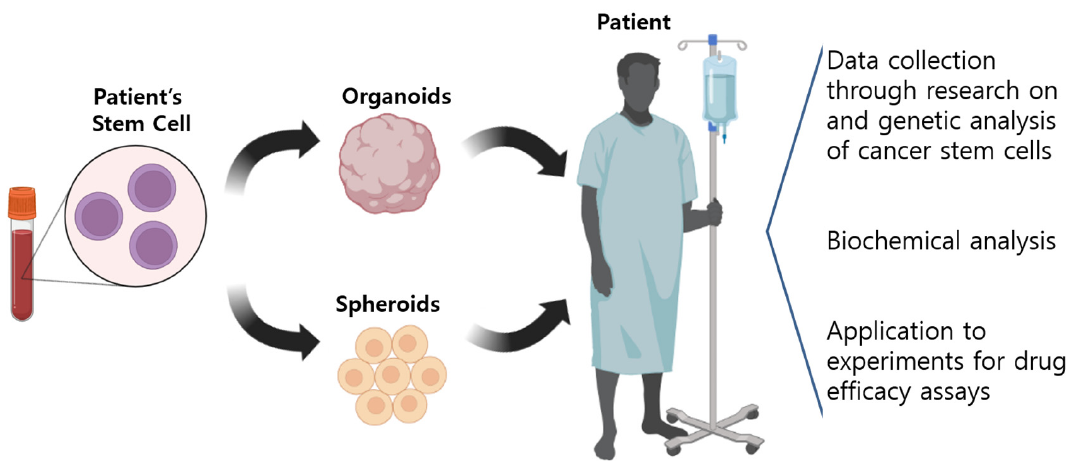
Figure 3. Clinical model for isolating spheroids and organoids from patients. Three-dimensional in vitro models, such as tumor spheres and organoids, can be used to evaluate drug responses at individual patient level by providing new opportunities to build and apply three-dimensional in vitro human tumor models used for oncology or immunotherapy studies and various drug screenings. Table 2. Comparison of the basic characteristics of spheroids and organoids.